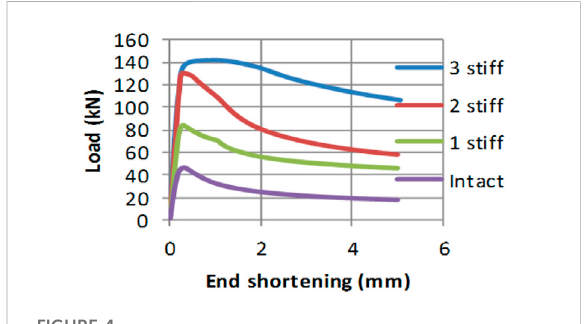
FIGURE 4 Load end shortening relationship of stiffened plates compared with the intact plate.